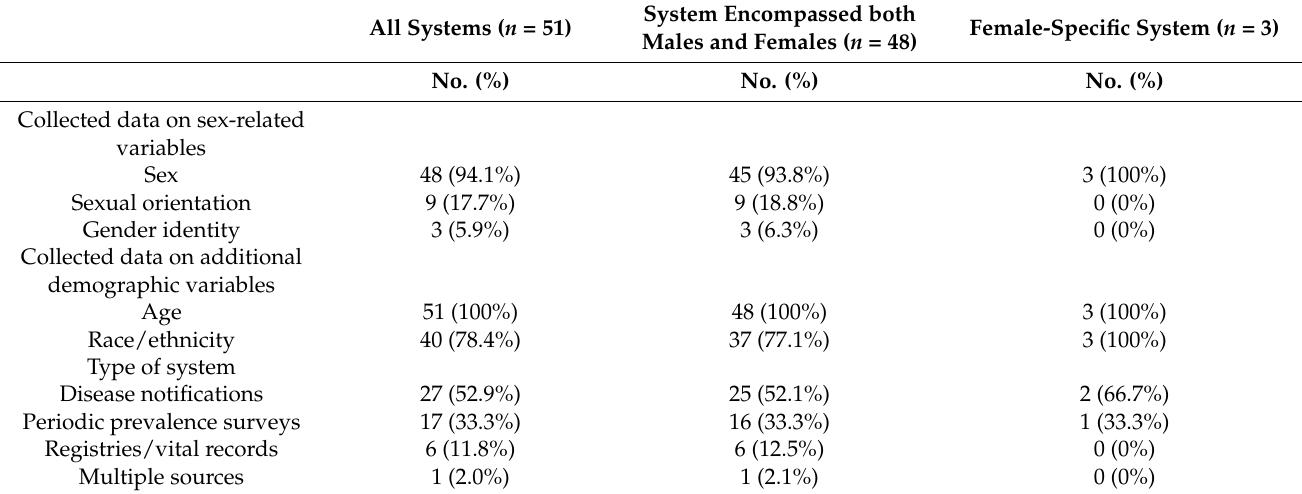
Table 2. Selected summary characteristics of U.S.-based public health data and monitoring systems active between 2015–2018.